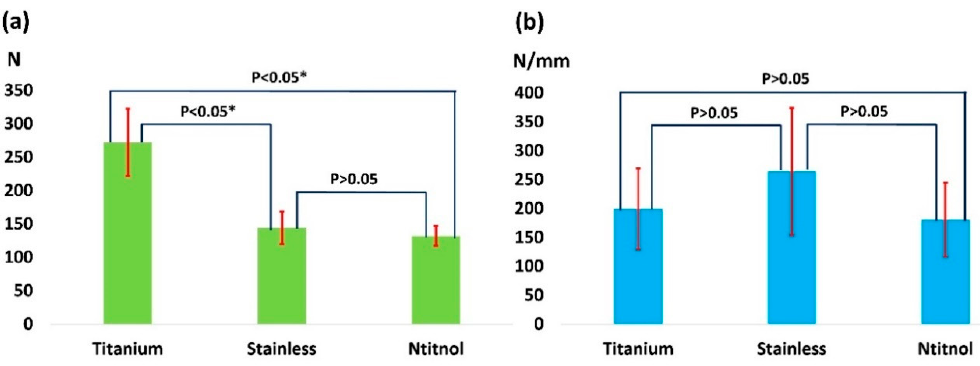
Figure 5. Ultimate load ( a ) and linear stiffness ( b ) of nails.